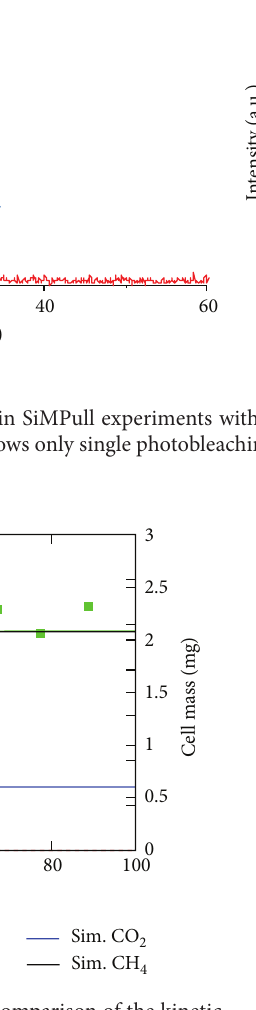
Figure 11: Results of the kinetic model. Comparison of the kinetic model for growth of M. acetivorans culture on 120mM acetate to the experiment [31]. Lines indicate model results while symbols indicate experimental